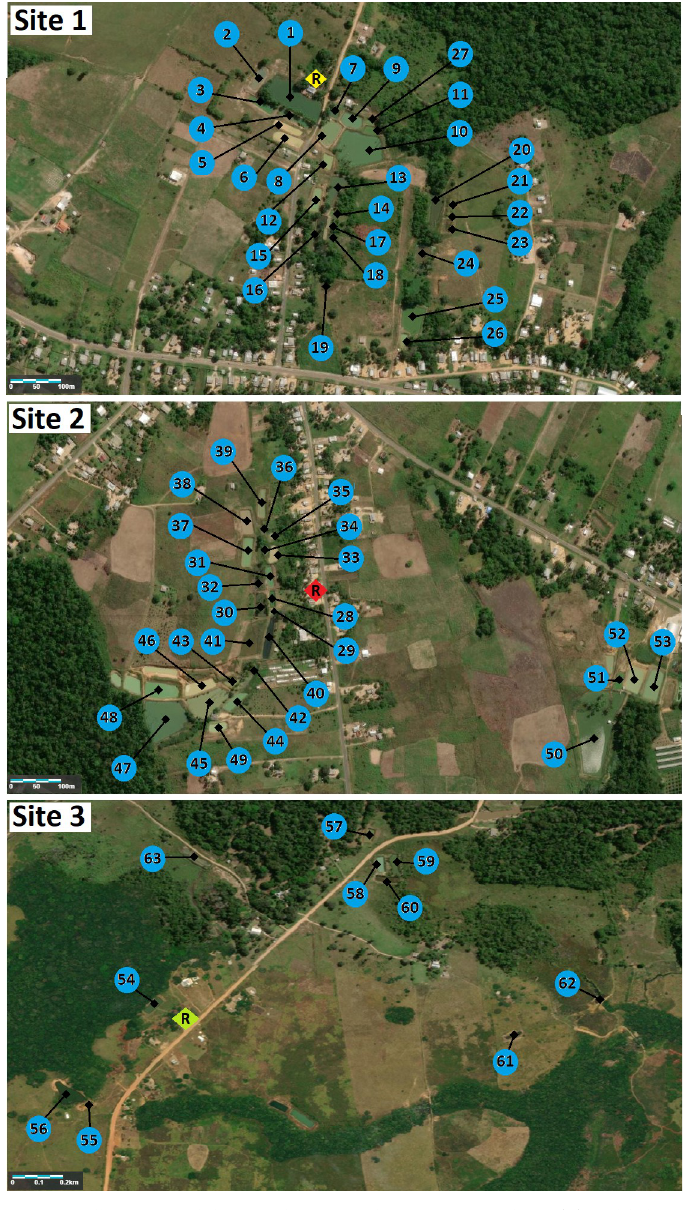
Fig 2. Satellite image of three study sites, with respective residence (R) and fishponds. Content is the intellectual property of Esri and is used herein with permission. Copyright © 2021 Esri and its licensors. All rights reserved. through May (except for Fishpond number 07, Site 1, in February) is noteworthy. The exclu- sive presence of Ny . darlingi was observed in some fishponds at urban Site 2, however, these count values were minimal (1 or 2 specimens). For the dry season (August and September), urban Site 1 had more fishponds that were positive exclusively for Ny . darlingi : 01 in August; 01, 04, 08, 11 18, 25, and 26 in September. Urban Site 2 also had some fishponds with Ny . dar- lingi exclusively, but also with low counts. Rural Site 3 had Ny . darlingi in August and Septem- ber in fishponds 54, 55 and 58 where this species was not observed during the rainy season months.